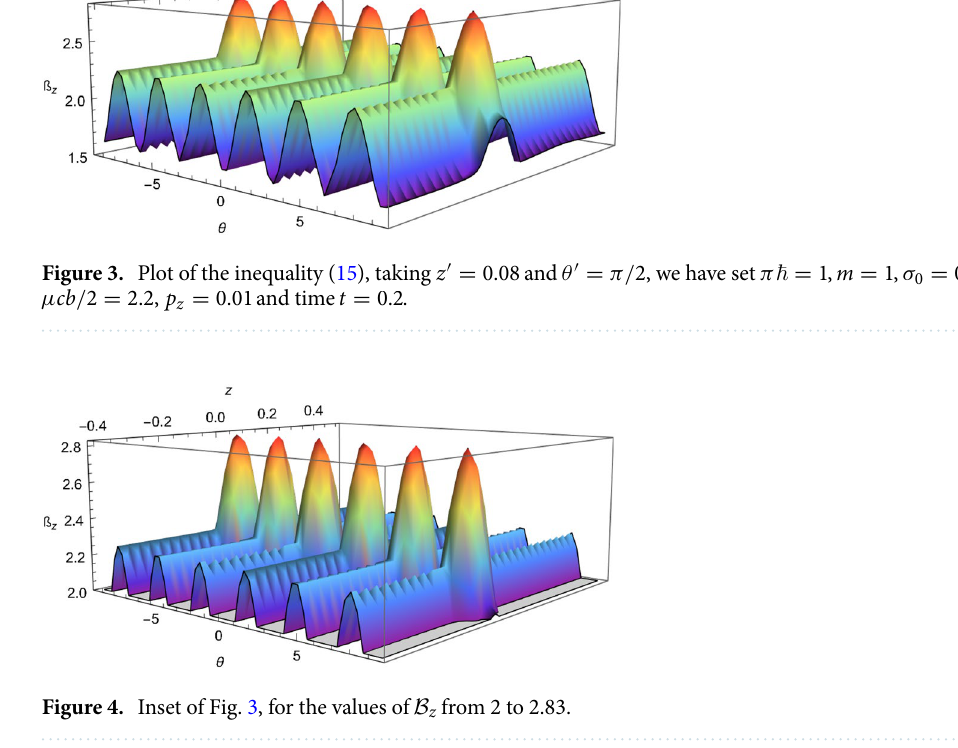
2 , we have set π (cid:31) ′ = π/